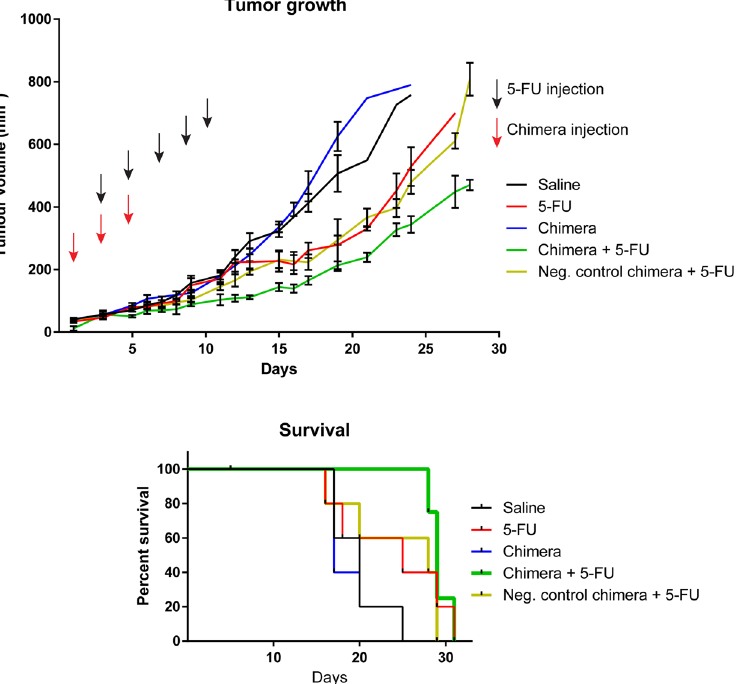
Figure 4. Combined chimera and 5-FU treatments improves therapeutic outcome in HT-29 tumour-bearing mice. ( a ) The graph represents the tumour volume in mice in response to various treatments as indicated. ( b ) Survival rate of mice observed over the course of various treatments. Data shown are mean ± SEM, n =